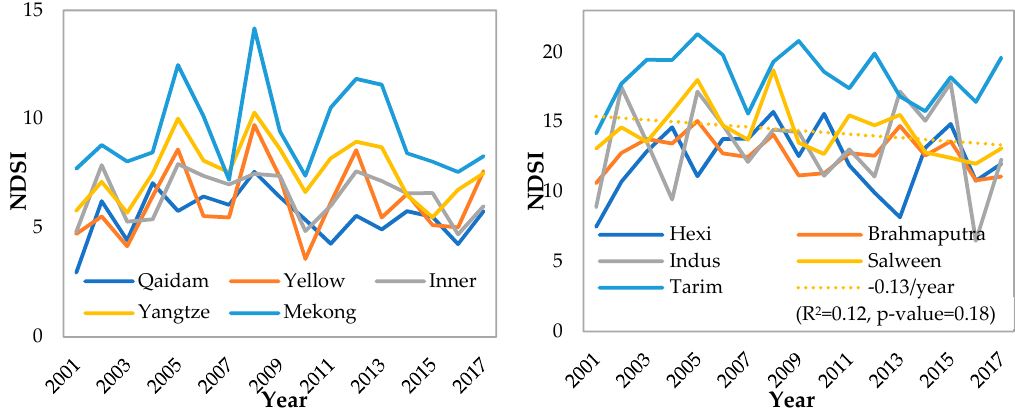
Figure 16. The annual average NDSI in the 10 subregions (see Figure 1) during 2001–2017. To further investigate the correlation of the inter-annual snow cover variation between the subregions and the entire TP, Table 5 lists some indicators describing the variation and regional topography. On the one hand, the inter-annual snow cover variation of the four subregions of Inner, Yangtze, Mekong, and Salween has a high consistency with that of the TP, obtaining a correlation coe ffi cient of above 0.82. On the other hand, the specific variability of the snow cover shows significant regional inconsistency. For example, Tarim has the largest average NDSI of 18.28, which is twice that of the TP; however, their average elevation di ff erence is only 83 m. In comparison, the snow cover variability over the Mekong subregion with a similar average elevation, is more consistent with the entire TP. At the same time, significantly inconsistent variability can be observed in Hexi.